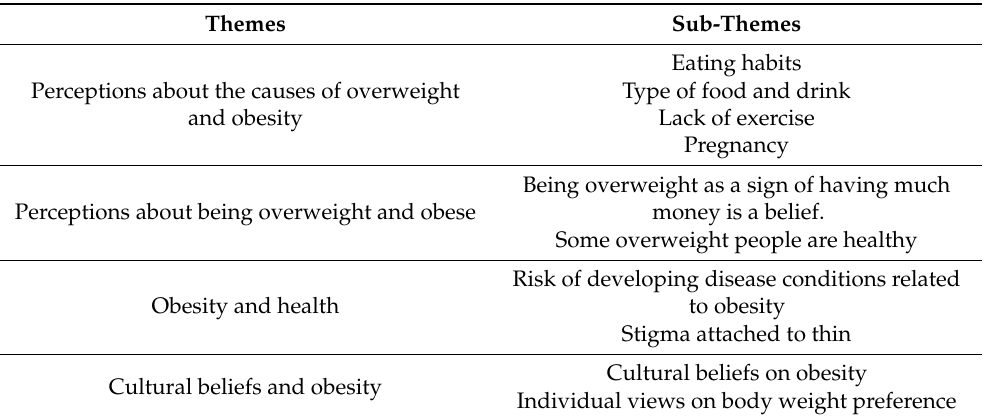
Table 2. Themes and